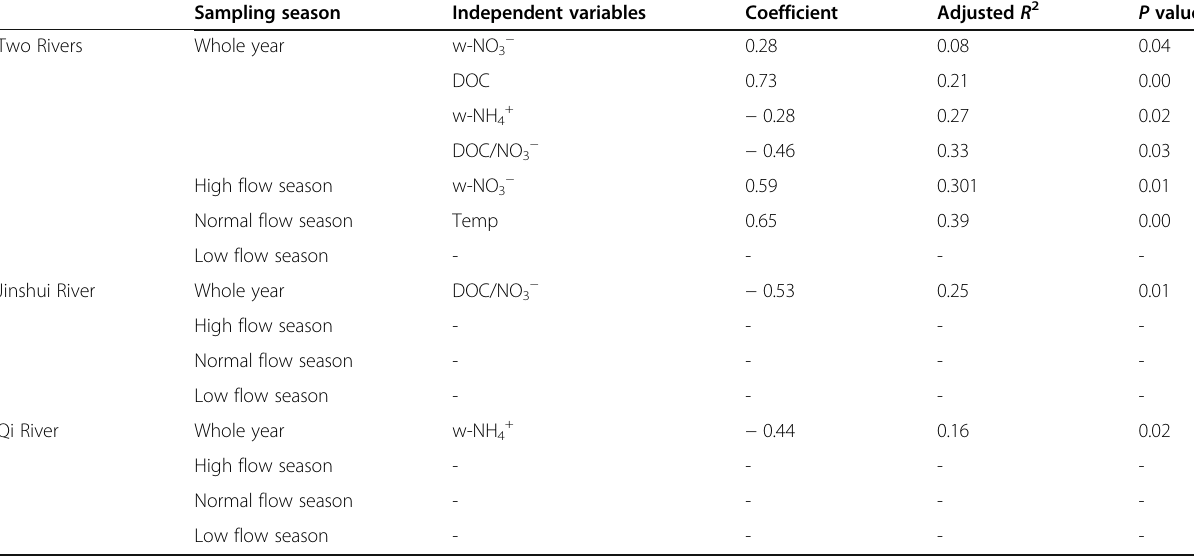
Table 4 Results of stepwise multiple regression analyses to predict N 2 O